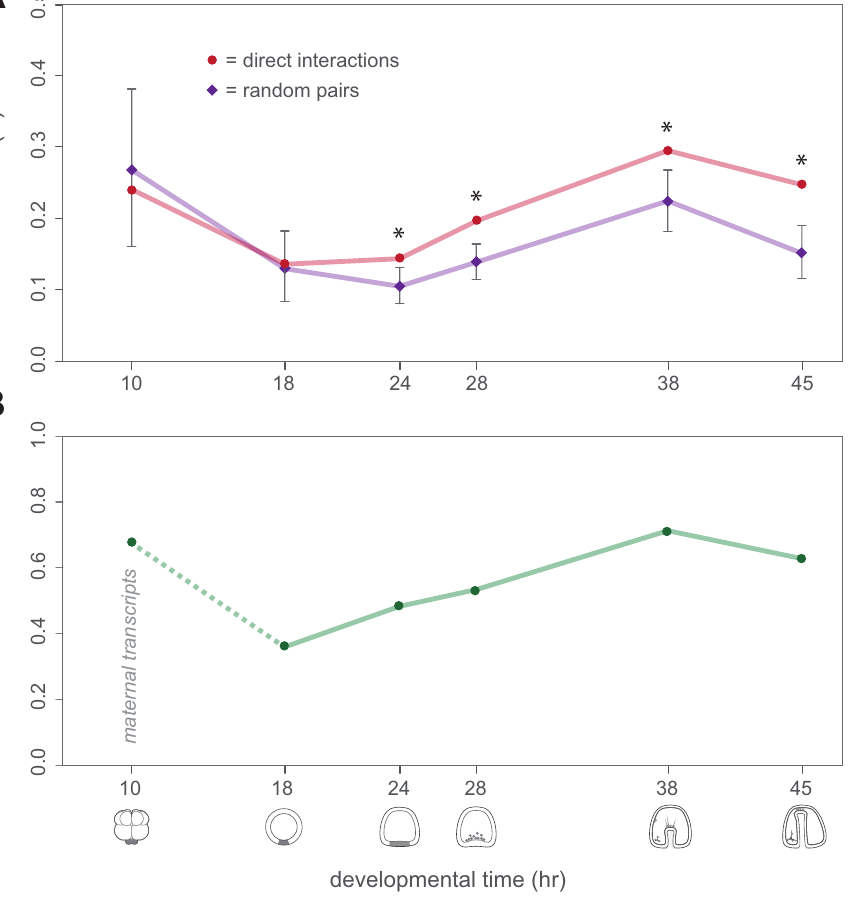
Figure 4. Changes in regulatory interactions across development. (A) Mean correlation (r 2 ) in expression between pairs of genes are plotted for known direct regulator-target interactions (red) and random pairs of genes not thought to interact (purple). Error bars for random interactions are based on boot strap replicates carried out independently for each stage; values for known interactors are counts at each stage and thus no error bars are shown. Asterisks denote significant differences between interactors and random pairs of genes ( p , 0.01, by permutation, for all but time point 3, for which p , 0.05). Note that known interactors are no more correlated than random pairs of genes during early development, but become more highly correlated from time point 3 onwards. (B) The proportion of sensitive regulatory interactions among known interactors is plotted. Many regulatory interactions among zygotically expressed genes are insensitive (i.e., switch-like) during embryogenesis, with an increasing proportion of sensitive (i.e., quantitative) interactions at later time